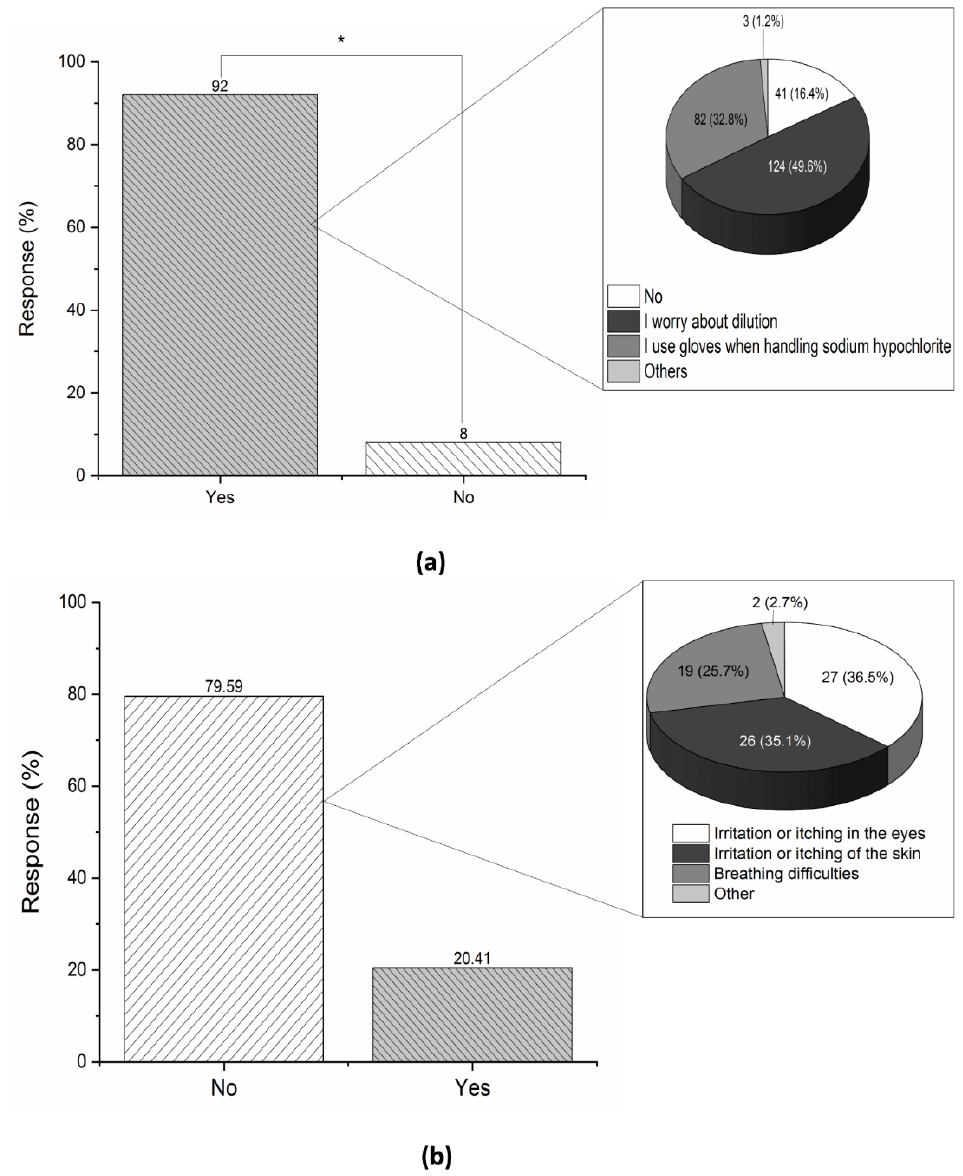
Figure 4. Responses of professionals to the following survey questions: ( a ) Do you use sodium hypochlorite for surface cleaning/disinfection in your home? If the answer to the previous question was YES, do you have any concerns about handling sodium hypochlorite? ( b ) Have you had any kind of reaction to sodium hypochlorite in previous contact? If YES, please indicate the type(s) of reaction(s). * represents p < 0.05 by Friedman test with Dunn’s multiple comparisons test.